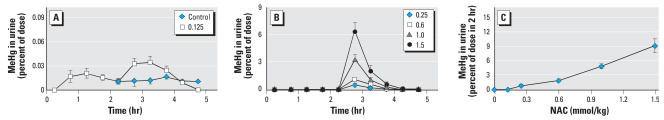
Dose-dependent effects of NAC on urinary MeHg excretion in male rats that received [14C]MeHg (0.1 μmol/kg body weight). Two hours after [14C]MeHg administration, animals received vehicle or different doses of NAC [vehicle or 0.125 mmol/kg NAC (A); 0.25–1.5 mmol/kg NAC (B)]. (C) Total amounts of [14C]MeHg excreted in urine during the 2 hr after NAC injection plotted against the various doses of NAC. Values are mean ± SD; n = 4–5 rats per group.